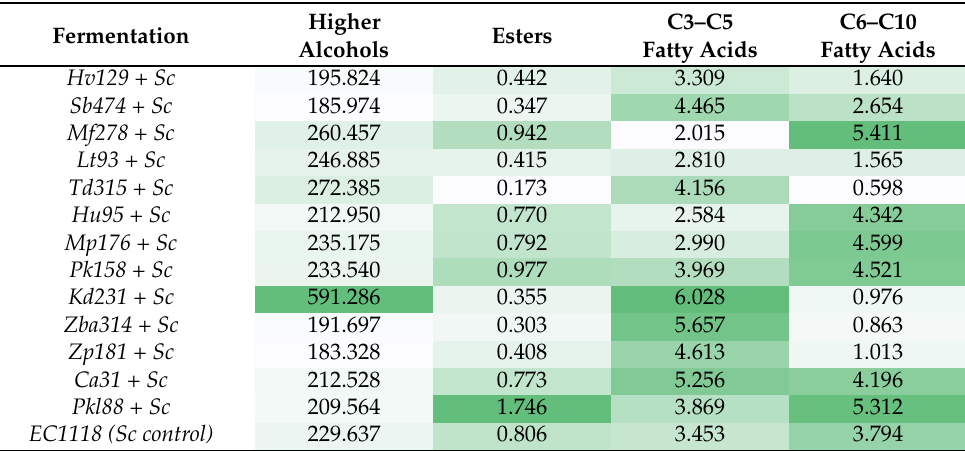
Table 4. Heat map of the concentrations (mg/L) of some volatile compound families in the wines obtained by sequential fermentation with non- Saccharomyces yeasts + S. cerevisiae EC1118 and with S. cerevisiae as a monoculture. The darkest green indicates the highest content, and white indicates the lowest content of each